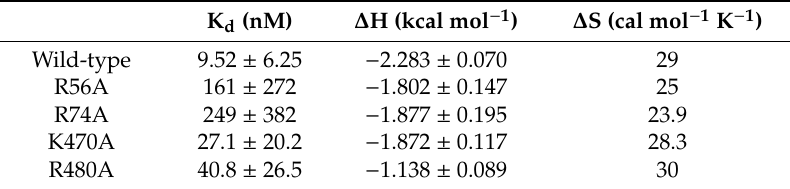
Table 3. Thermodynamic parameters for binding of EDTA by site-directed EppA mutants. a K d